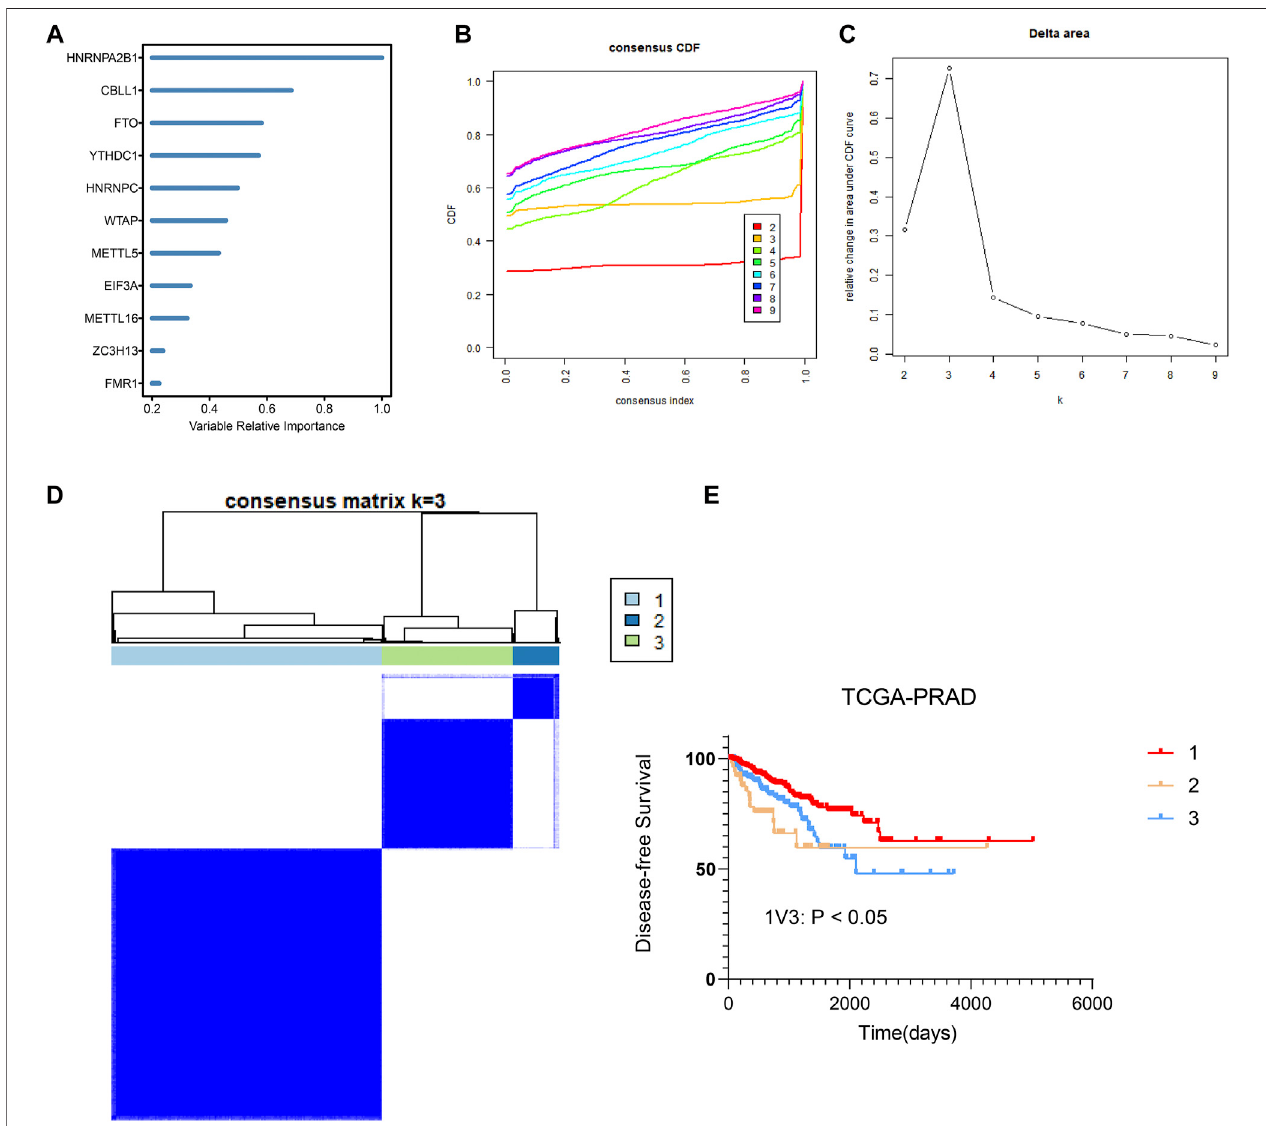
FIGURE 4 | Identi fi cation and consensus clustering analysis of m6A regulators (A) Random forest analysis ranking the importance of m6A regulators in prostate cancerbased on their geneexpression levels. (B,C) Relative change inarea under cumulative distribution function (CDF) curve based onresults ofconsensus clustering for k (cid:1) 2 to 9. (D) Consensus clustering matrix for k (cid:1) 3. (E) Comparison of DFS between group 1 、 group 2 and group 3 samples in prostate